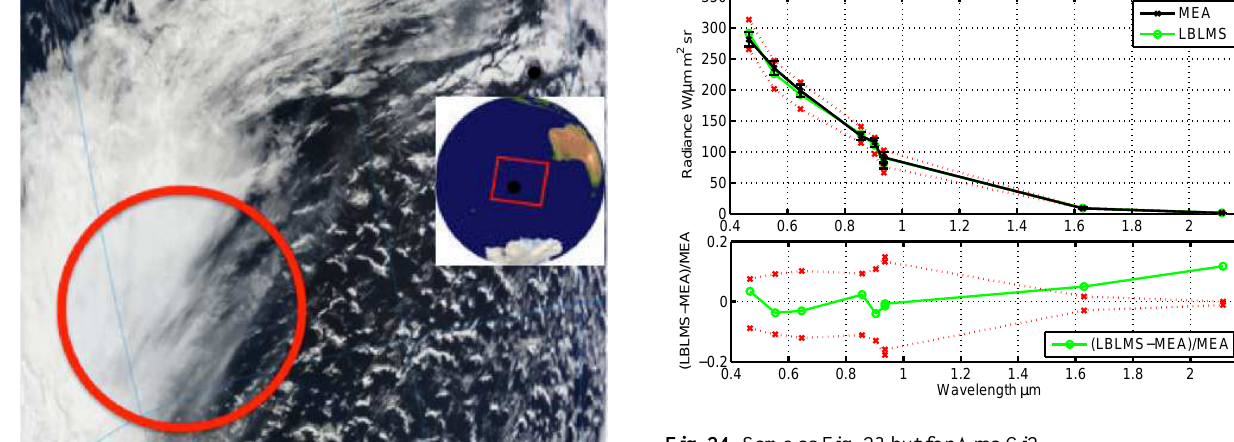
Fig. 24. Same as Fig. 23 but for Area